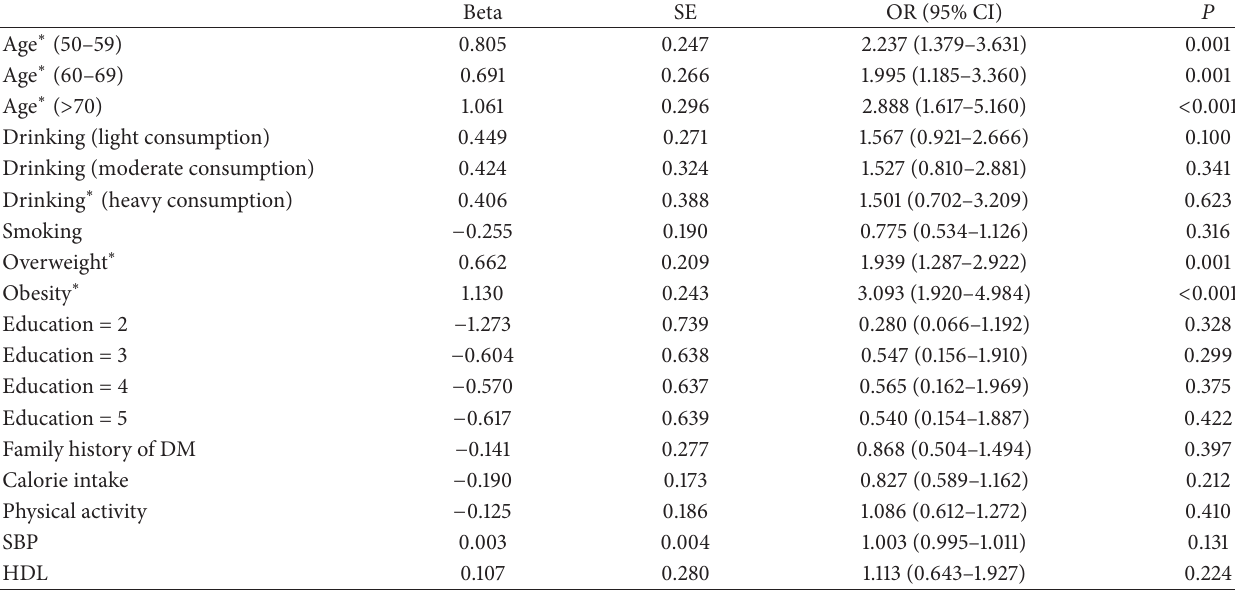
Table 6: Multivariate logistic regression analysis of diabetes (light, moderate, and heavy alcohol consumption as three separate